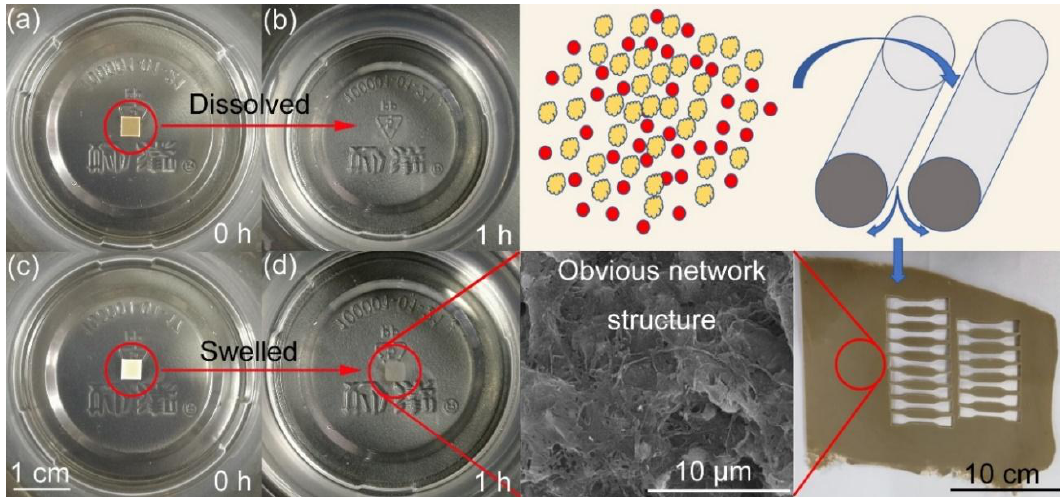
Figure 1. Digital images ( left ) and SEM images ( right ) of propellant dissolved in acetone. ( a ) DB propellant, 0 h; ( b ) DB propellant, 1 h; ( c ) PTFE-DB propellant, 0 h; and ( d ) PTFE-DB propellant, 1 h.